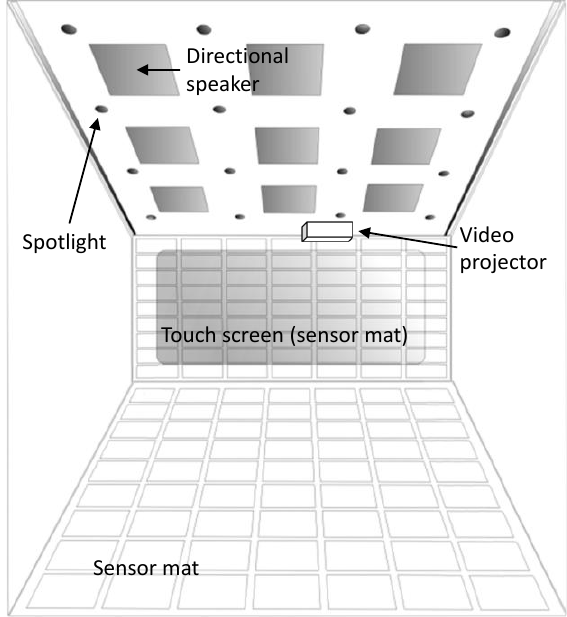
Figure 7. Proactive space with various sources of stimuli (figure made for this review by Matti